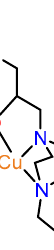
Figure 26 . Tricopper Cluster Complex CuIICuIICuII(7-N-Etppz) 4+ .